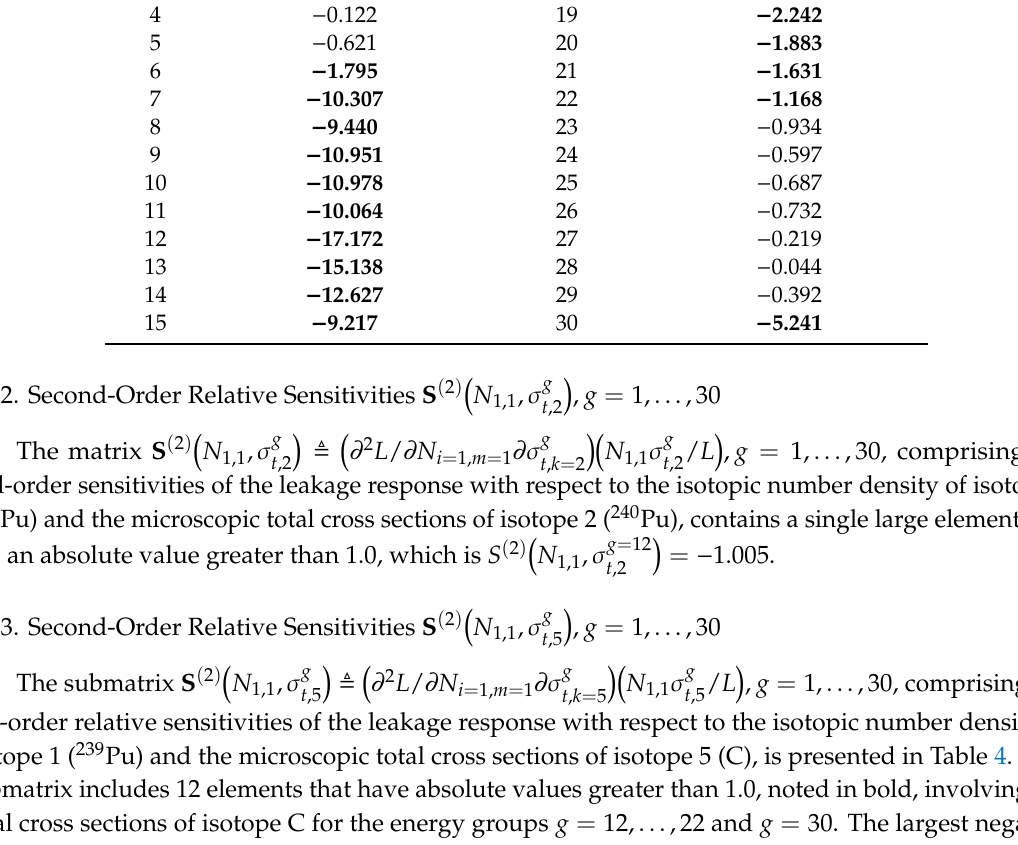
Table 4. Second-Order Relative Sensitivities S ( 2 )